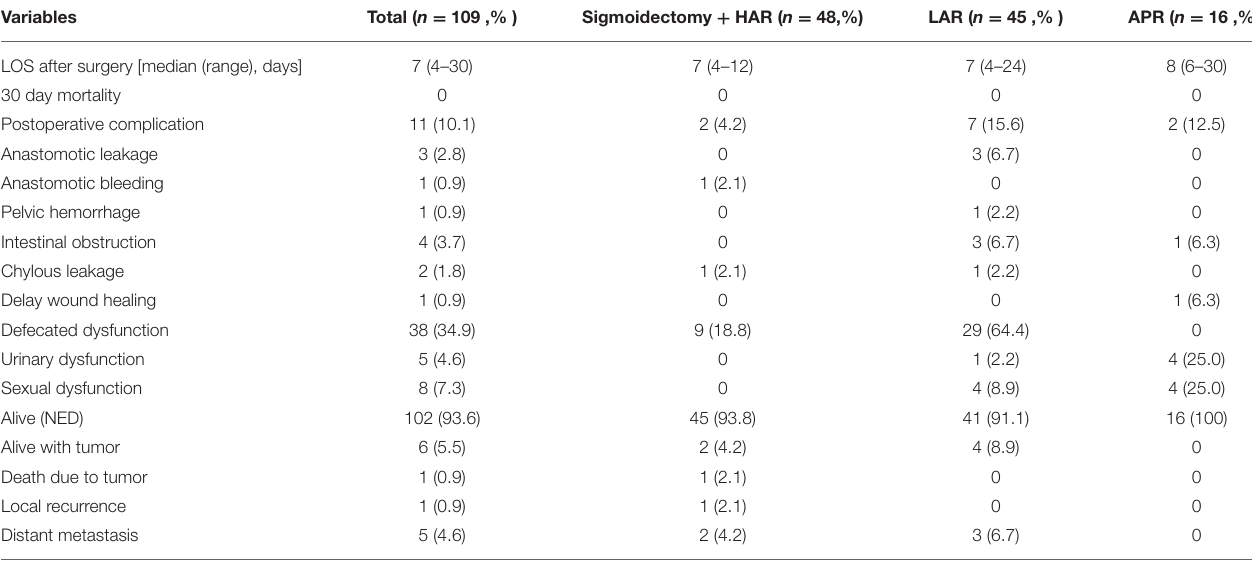
TABLE 4 | Postoperative and oncologic outcomes.